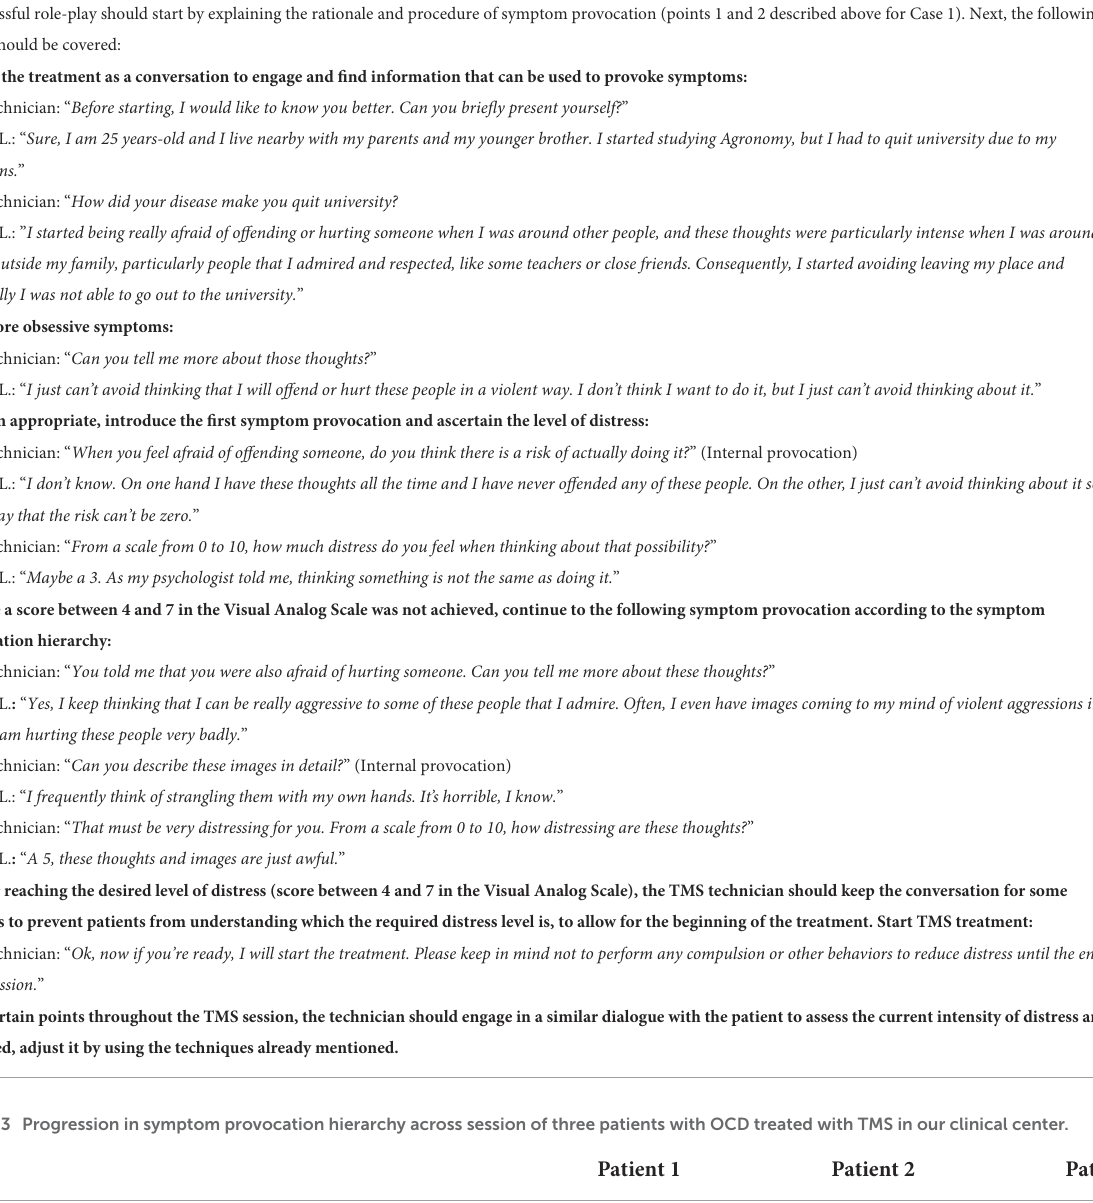
TABLE 2 Role-play case 2.